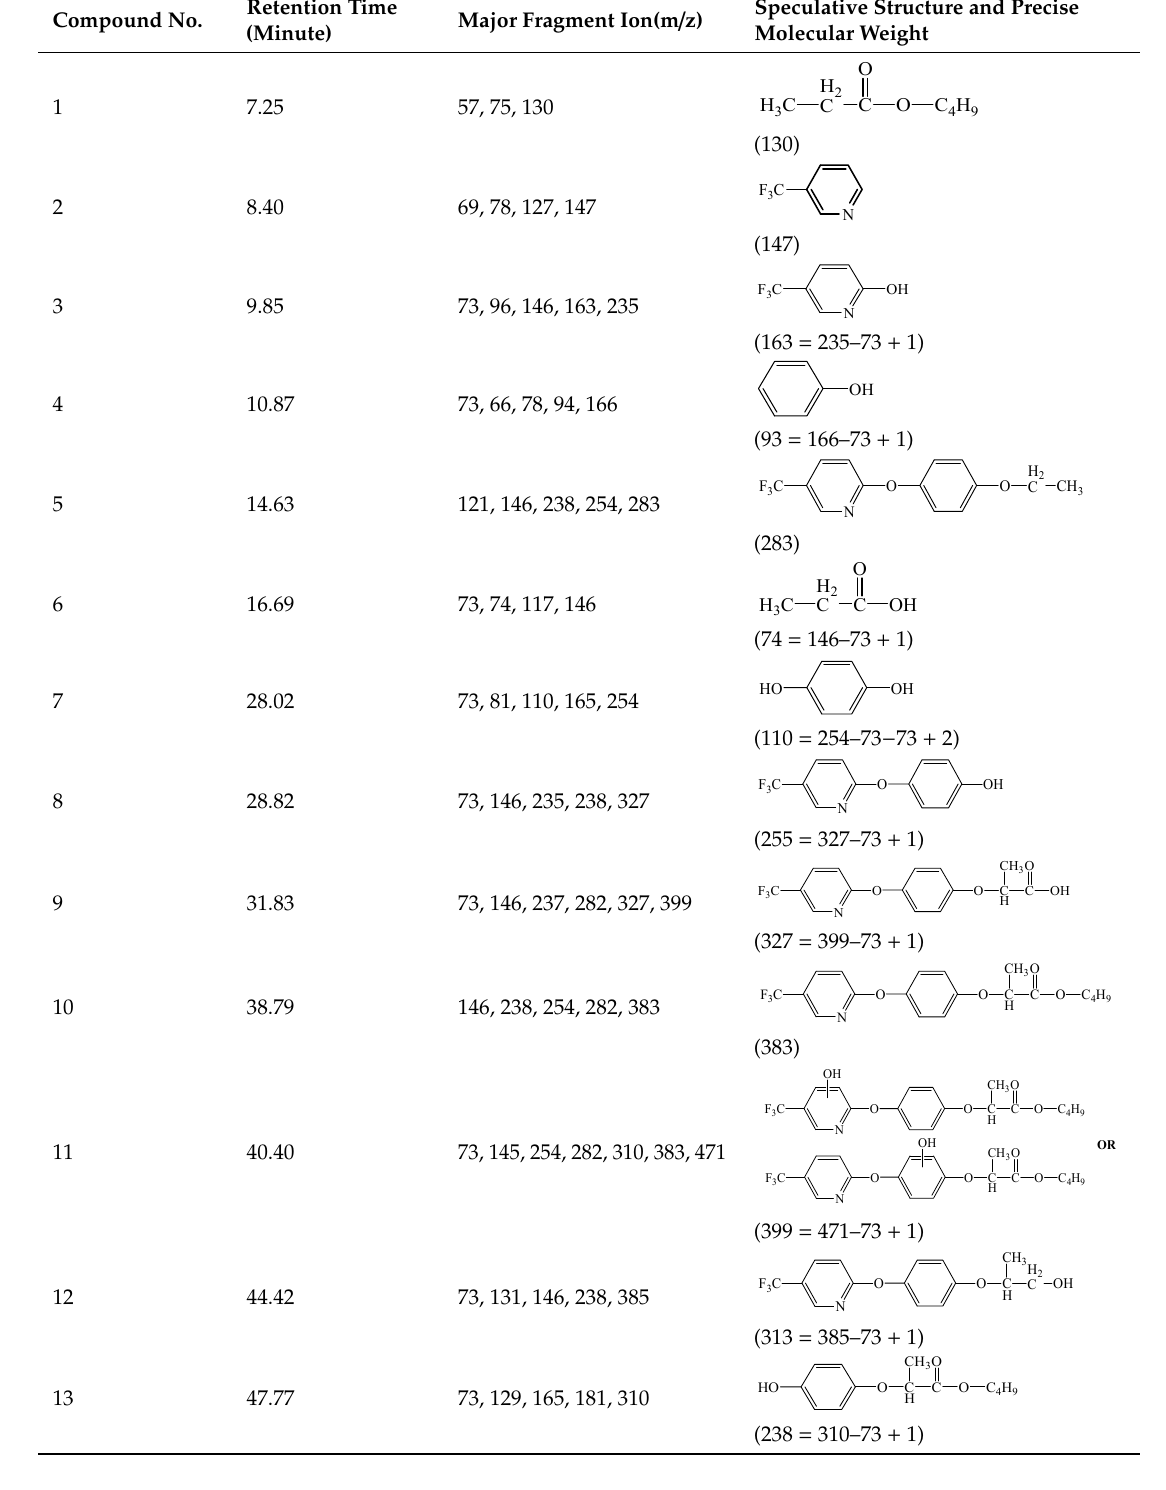
43 Figure 5. Possible cleavage sites for FPB molecules undergoing photocatalytic degradation.